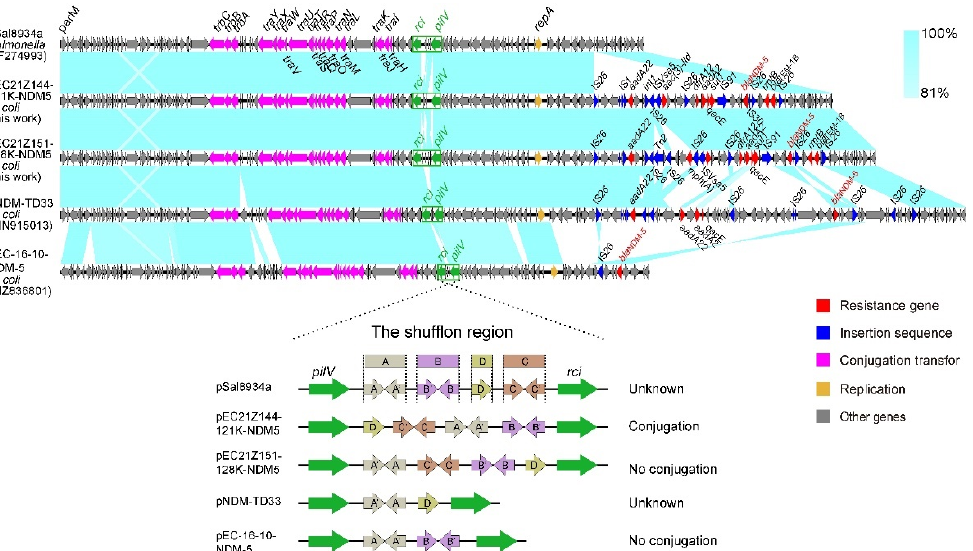
Figure 6. Sequence comparison of the IncHI2A plasmids carrying bla NDM-5 genes from the strains EC21Z-144 and EC21Z-151. The original plasmid (pSal8934) is compared with the pEC21Z144-121K-NDM5 and pEC21Z151-128K-NDM5. The shufflon regions are marked by a green box, and the box marking A, B, C and D referred to the four segments of shufflon. The arrows and triangles represent genes from different functional categories (red: ARGs, dark blue: insertion sequence, orange: replication, pink: conjugation transfer, green: shufflon region, grey: other genes).